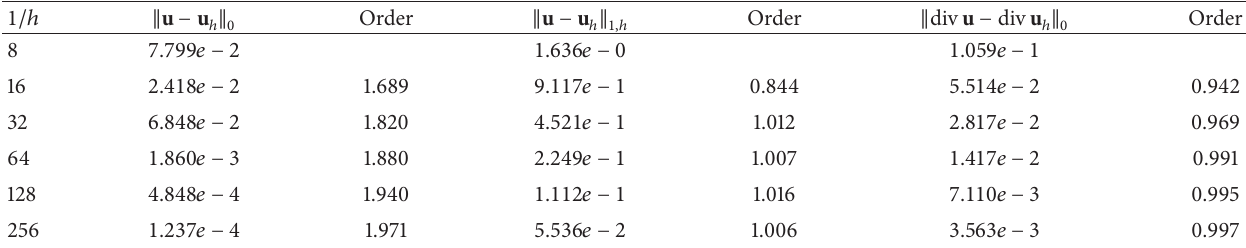
Table 4: 𝜇 − = 1 , 𝜇 + = 10 , and 𝜆 = 1000 𝜇